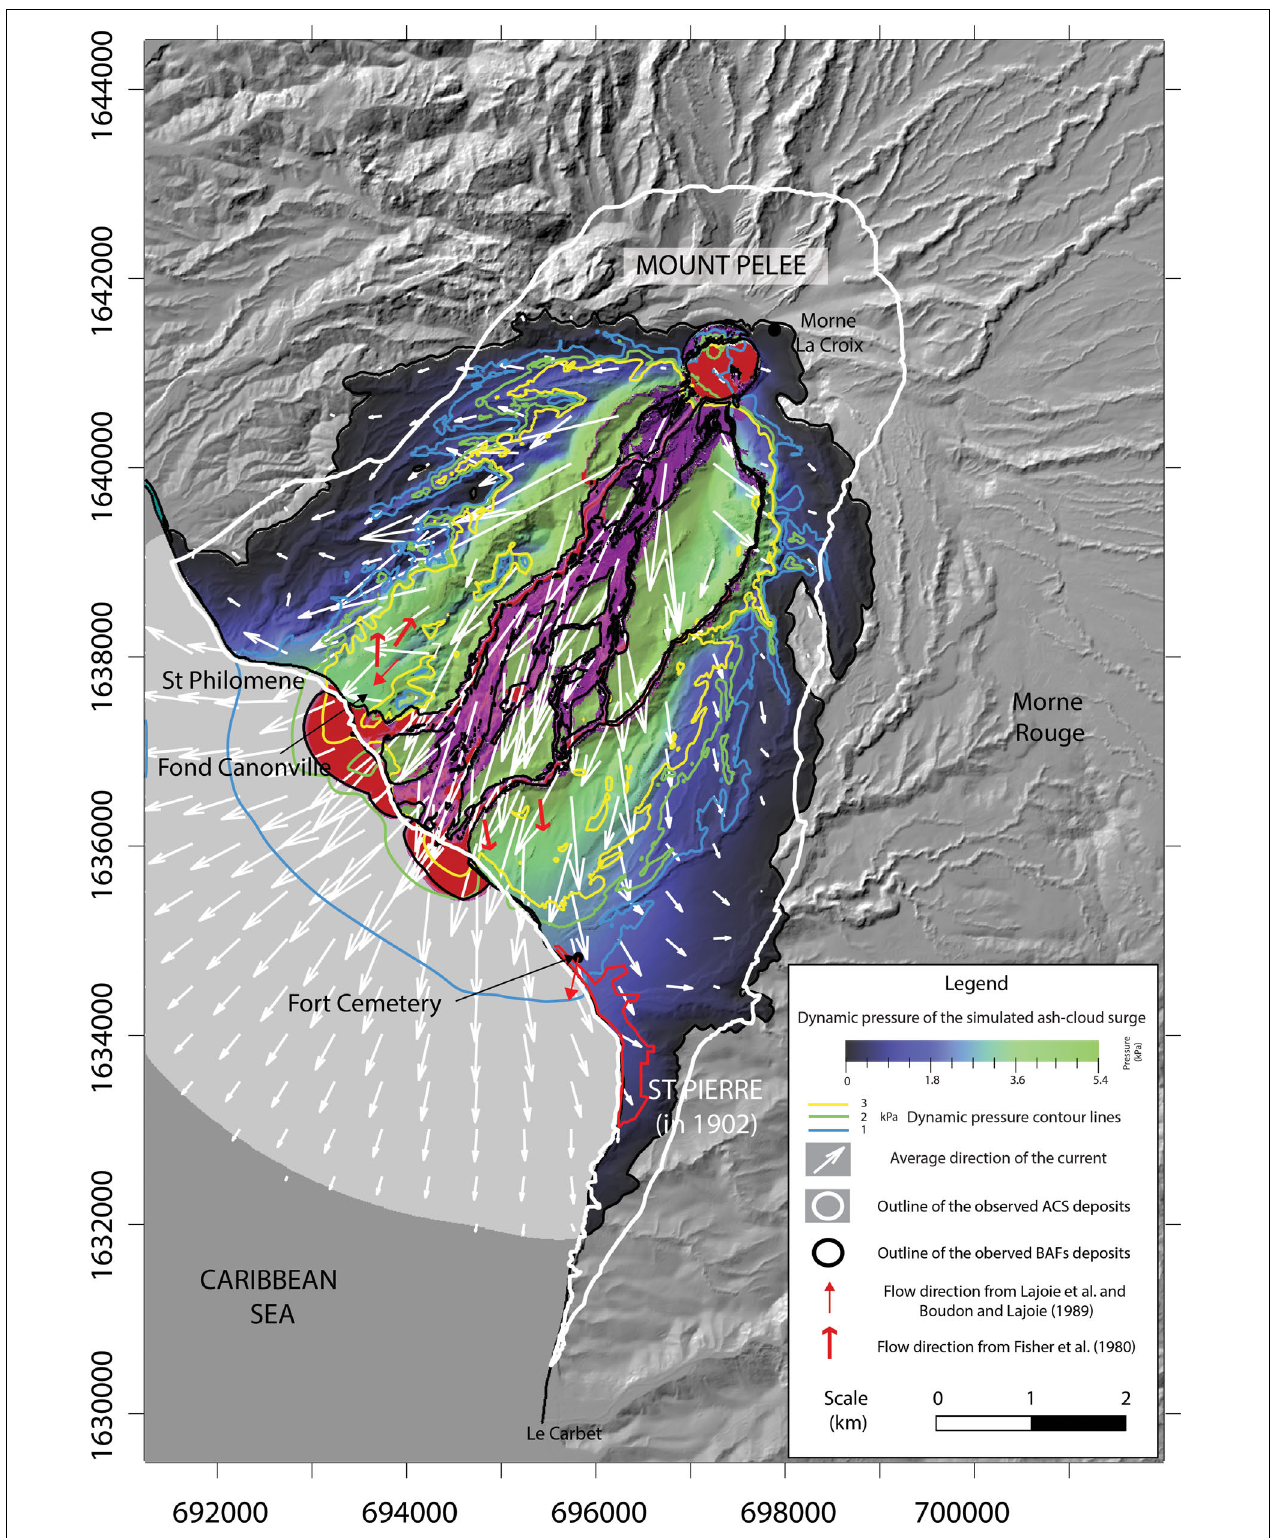
FIGURE 8 | Map of the maximum dynamic pressure and a mean direction of the ash-cloud surge from the best fit simulation. The distribution of the dynamic pressure is shown as a color scale, and isobar lines indicate the 1,2 and 3 kPa (blue, green and yellow lines, respectively) pressure fields. The average direction of the current is represented by white arrows, whose lengths correspond to the velocity of the ash-cloud surge, calculated from the center of the arrow.